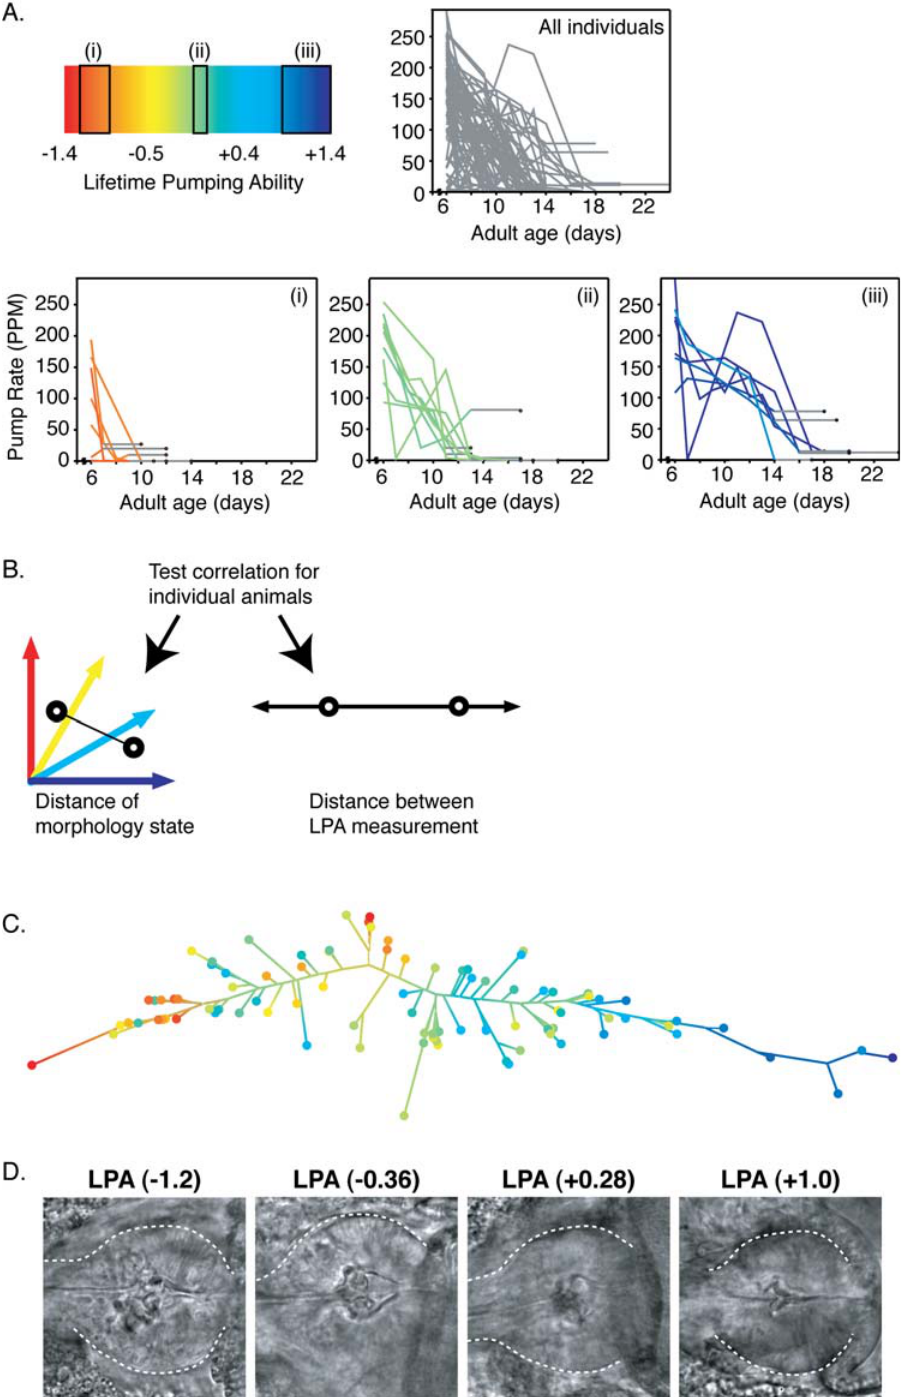
Figure 6. Image analysis identified morphological features correlated to pharynx function during aging. (A) Longitudinal pumping data are shown for individual animals sorted into low, medium, and high LPA ranges. Each animal’s trace has a colored portion based on its LPA score that ends on the last day the individual was observed alive, and a horizontal grey portion that ends on the day the individual was observed dead. The light grey background lines depict pump rates measured for the entire population. Colors correspond to actual LPA value for each individual as depicted in the heatmap. The rectangles designate the actual LPA values for the individual data highlighted in the lower plots. These figures show that pump rates can have significant day-to-day variation, and that LPA values were positively correlated with pharynx function and healthspan after day 6. (B) Correlation between morphological differences and differences in future function was established by measuring distance between each pair of images in the LPA classifier’s marginal probability space, and comparing it to the corresponding difference in LPA values. (C) Dendrogram representing image similarity. 91 images are represented by branch endpoints with their relative positions predicted by the model. Endpoint colors indicate the LPA value for each image; branch colors are determined from the relative contributions of neighboring endpoints. This dendrogram shows that the LPA classifier was able to correctly order images with respect to their measured LPA values, from low (red and orange) to high (blue), as designated in part (A). (D) Representative images show a progression from high to low levels of structural deterioration that corresponds to their measured LPA values. doi:10.1371/journal.pone.0002821.g006 PLoS ONE |